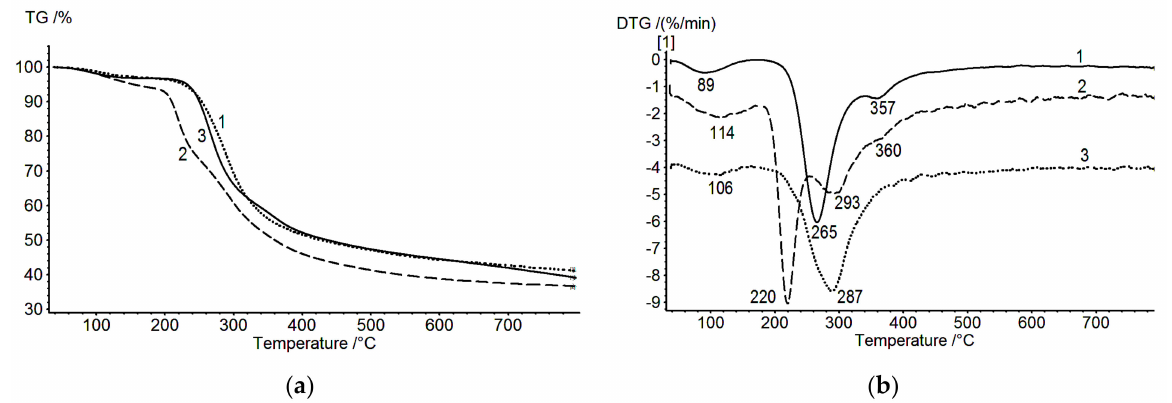
Figure 3. TG ( a ) and DTG ( b ) curves: CS b –PEC SEC (1), CS b –PEC HA (2) [9], and CS b –PEC ALG